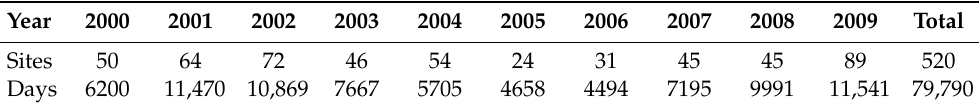
Table 1. Number of temperature logger sites and days of data per year for the John Day River daily datasets included in these